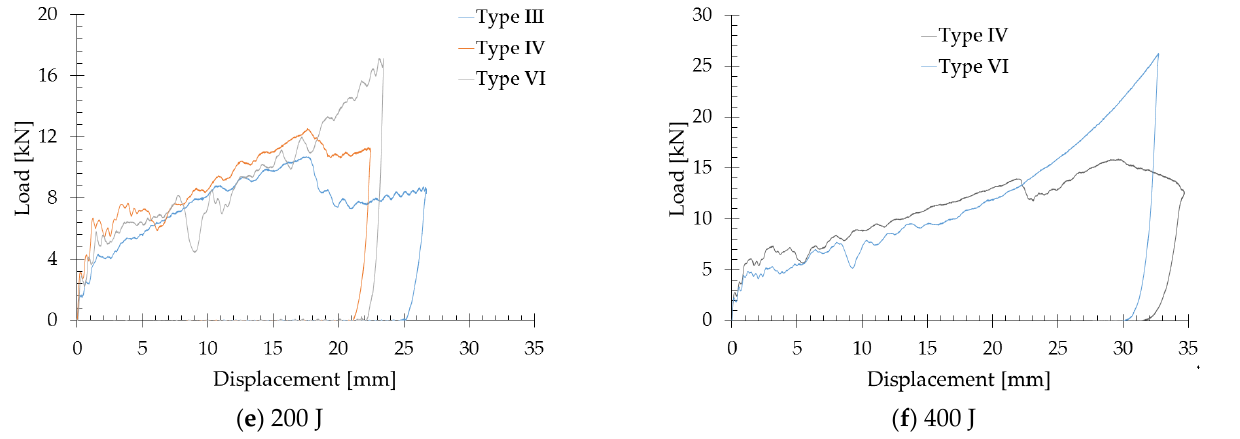
Figure 4. Load–displacement curves at different impact energies. The load–displacement curves for each type of the investigated panels at different impact energies are presented in Figure 5.